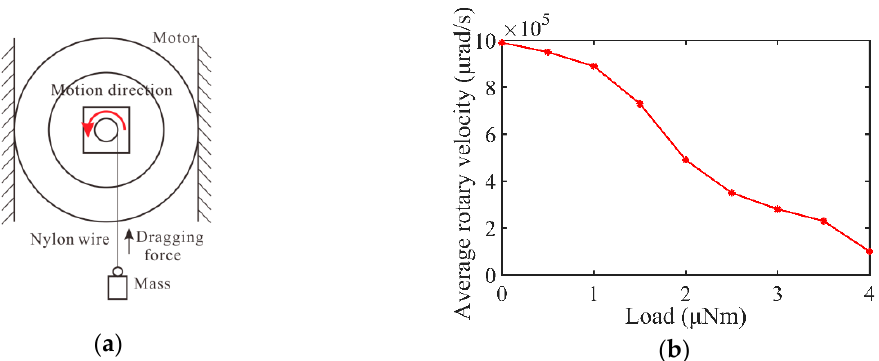
Figure 11. Load capacity of rotary motion: ( a ) testing system; ( b ) average rotary velocity under different external loads at 2 kHz.